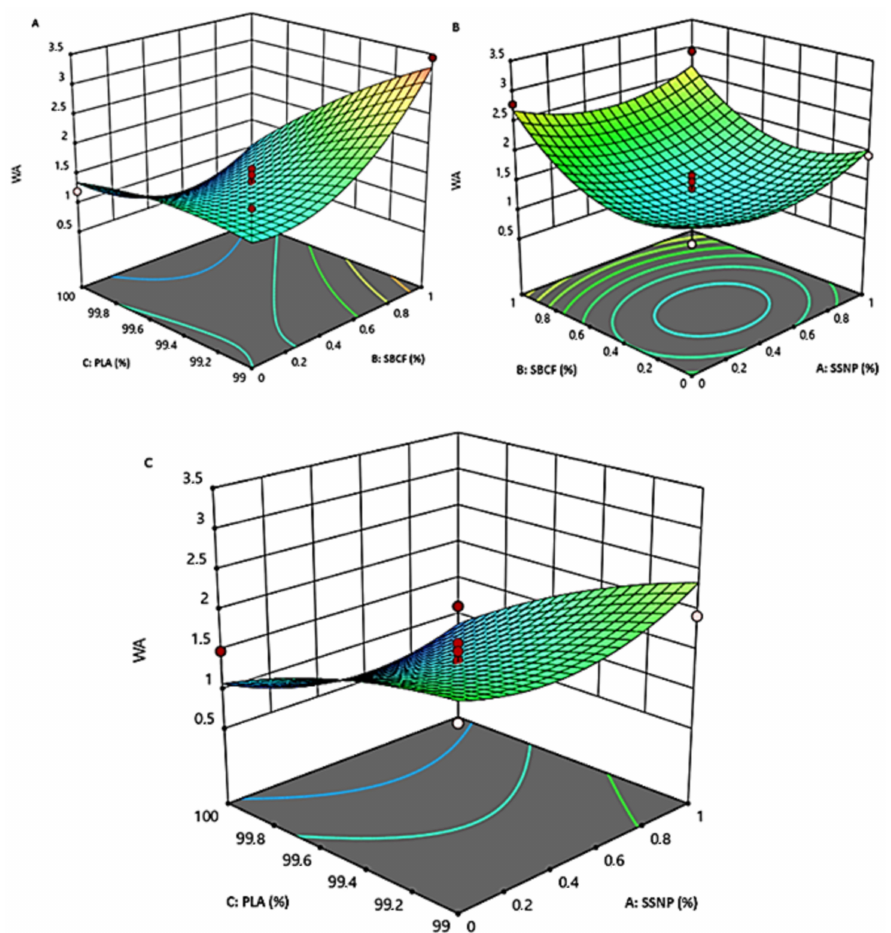
Figure 3. The 3-D surface plot of water absorption (WA) as a function of SSNP, SBCF, and PLA loadings: interaction effects of PLA and SBCF ( A ), SBCF and SSNP ( B ), PLA and SSNP ( C